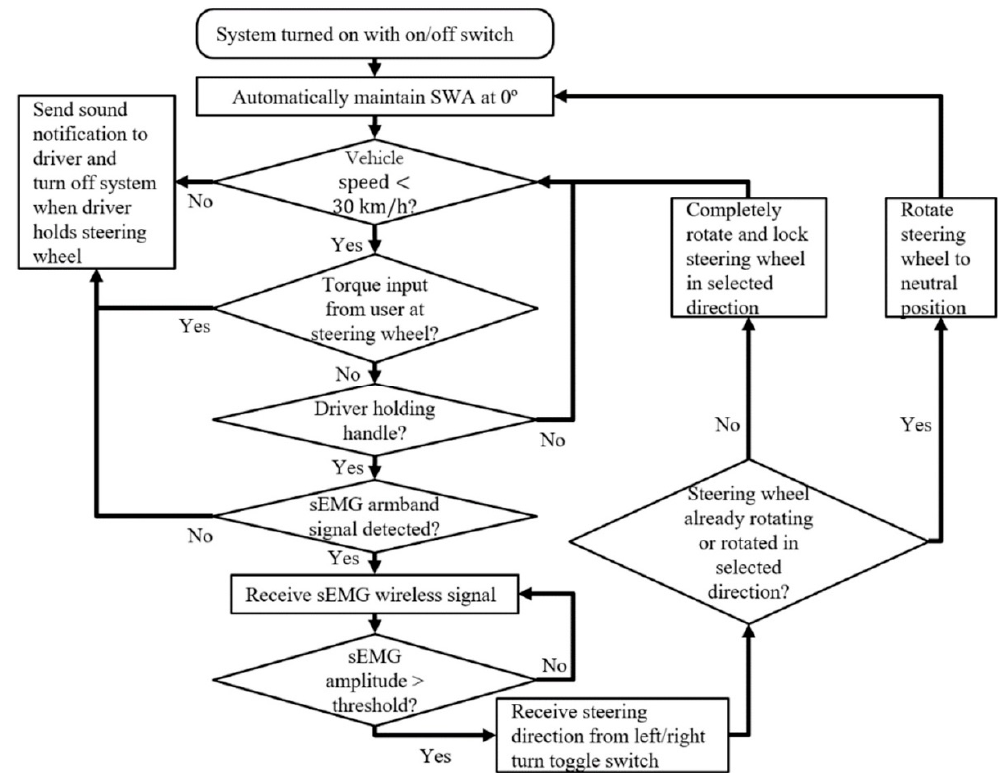
Figure 4. Operation flowchart of steering assistance interface.